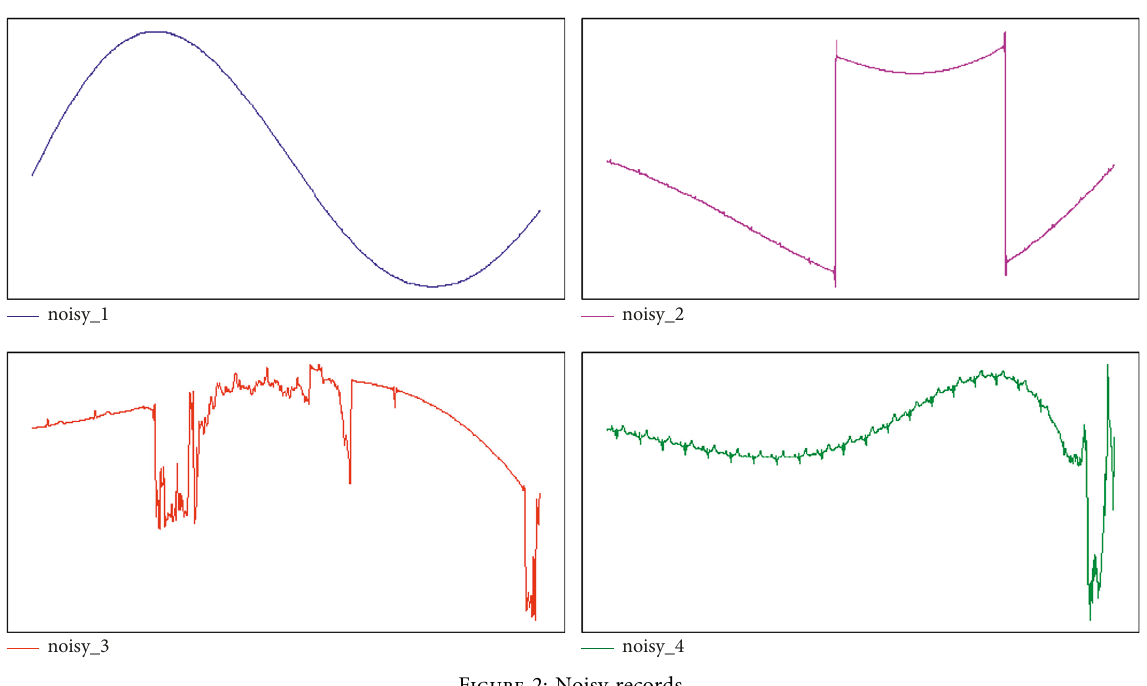
Figure 2: Noisy records.